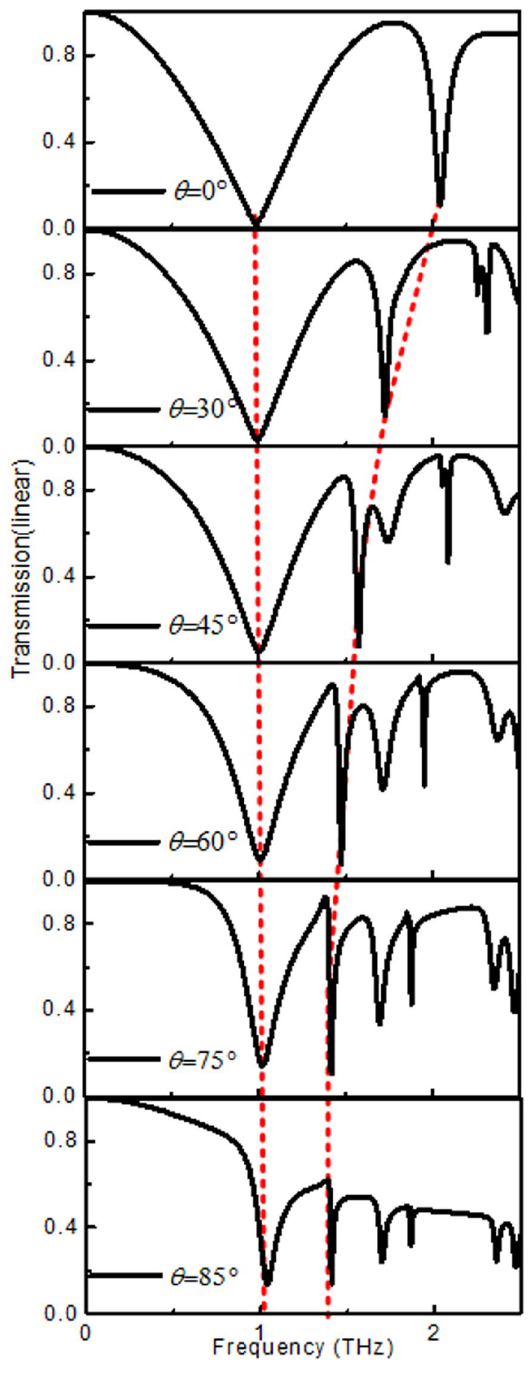
Figure 12. Transmission spectra of the multilayer structure for variation of θ